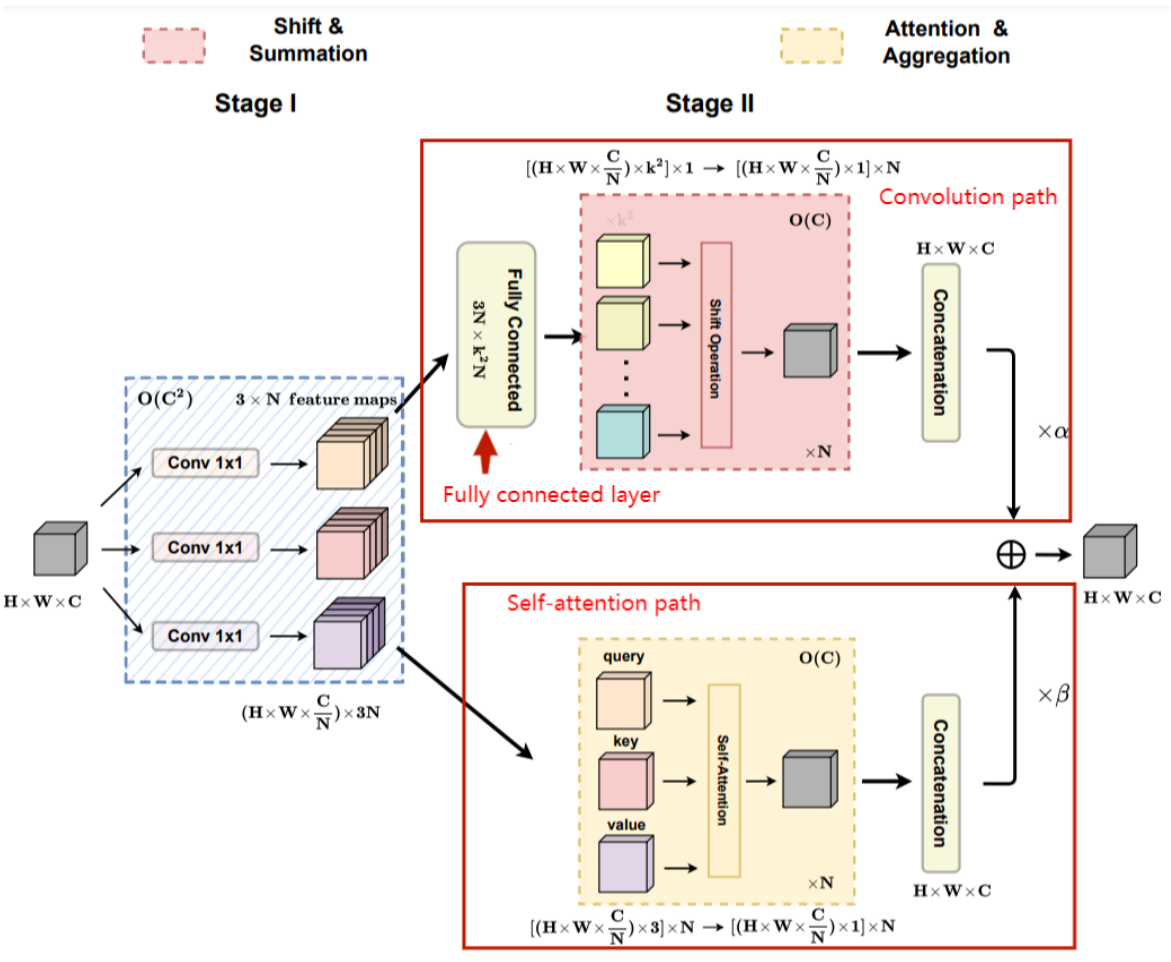
Forests 2023 , 14 , x FOR PEER REVIEW Figure 4. The structure of ACmix. Figure 4. The structure of ACmix.